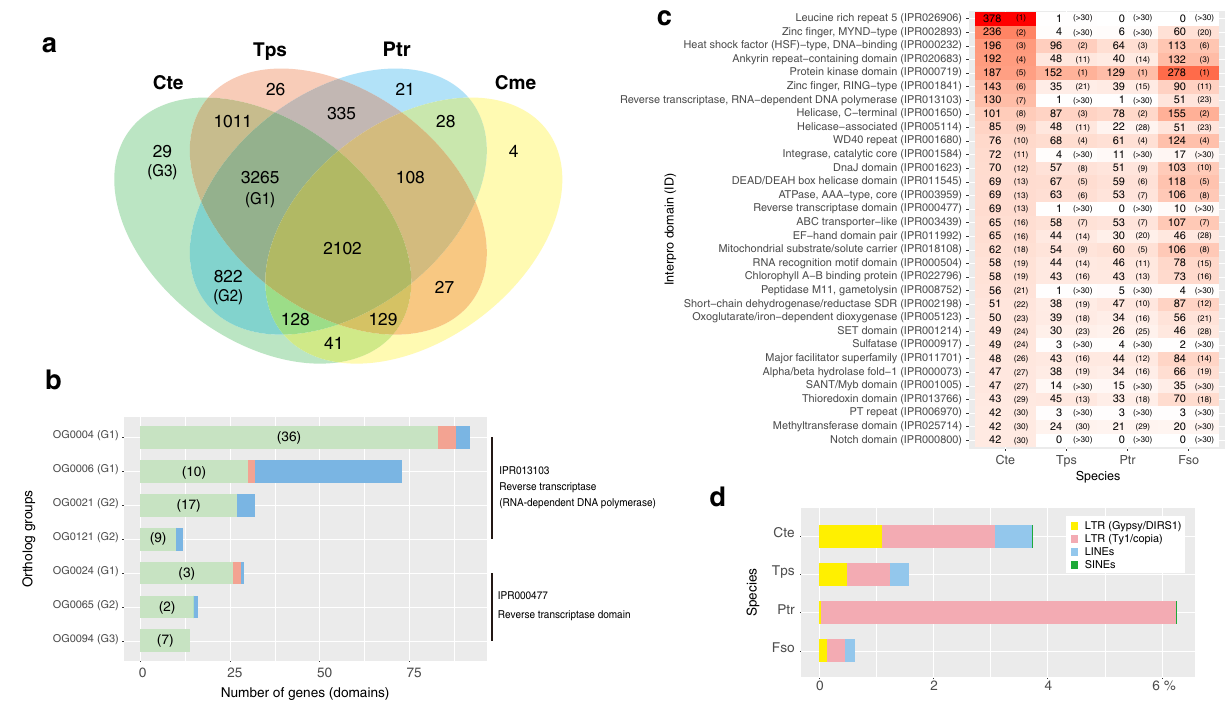
Figure 5. ( a ) Venn diagram of orthologous gene groups. Orthologous gene groups were identified from C. tenuissimus (Cte), T. pseudonana (Tps), P. tricornutum (Ptr), and C. merolae (Cme). The numbers in the Venn diagram indicate the number of orthologous gene groups. Reverse transcriptase domains (Interpro ID, IPR013103 and IPR000477) were included in the ortholog gene groups (G1, OG0004, OG0006, and OG0024; G2, OG0021, OG0121, and OG0065; G3, OG0094). ( b ) The number of genes in the above ortholog gene groups. The parentheses indicate the number of genes that possessed reverse transcriptase domains (IPR013103 and IPR000477). ( c ) Top 30 of the Interpro domains detected in the C. tenuissimus genome. The gene numbers are in descending order based on Cte and the numbers in parentheses indicate their ranking. The shade of red becomes lighter as the gene number decreases. Fso, Fistulifera solaris. ( d ) The percentage of retroelements in the four species genomes predicted by